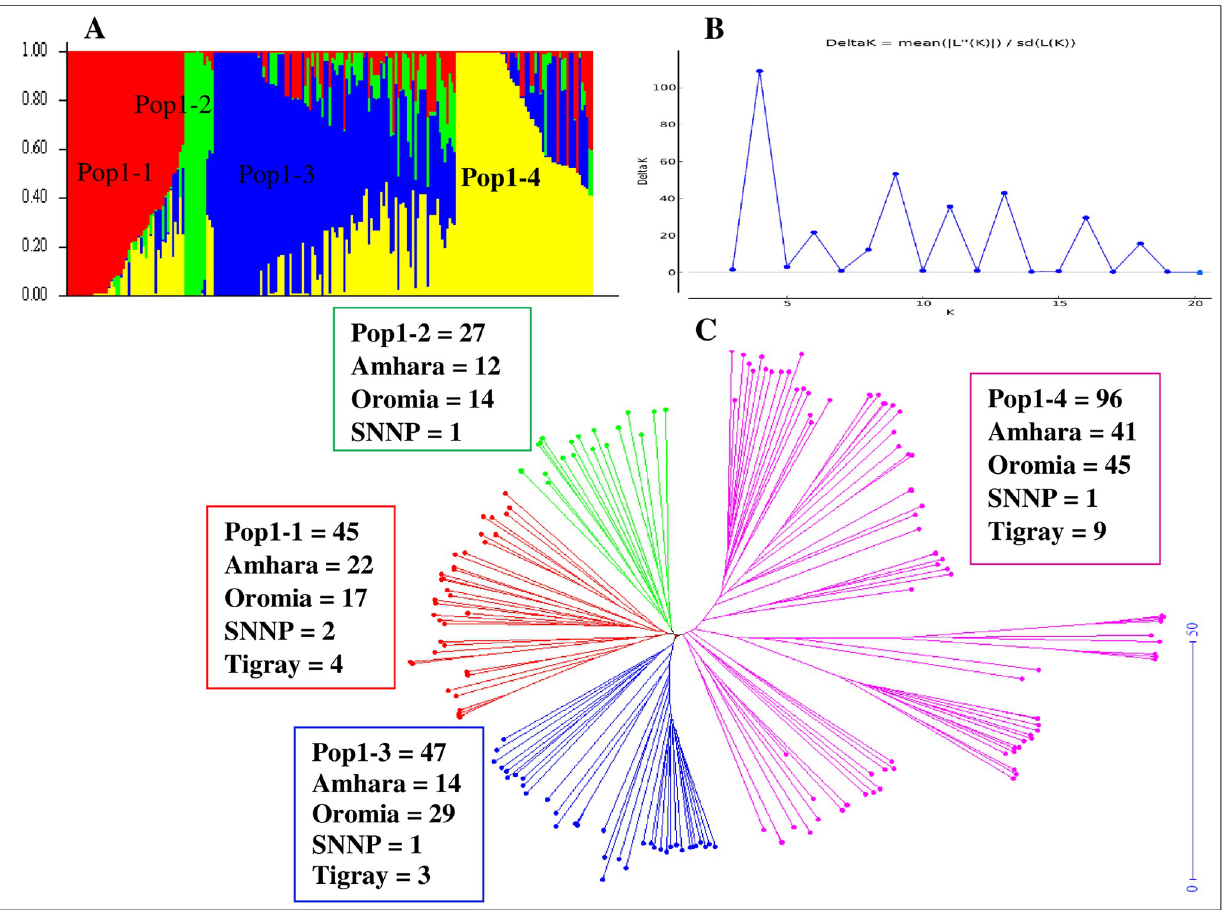
Fig 4. Population structure analysis of ETDWL. (A) Bayesian structure analysis, (B) Structure harvester Δ K at K = 4. (C) Neighbor-Joining (NJ). Populations identified in STRUCTURE based on Bayesian structure analysis are shown in red, green, blue and yellow/pink, for Pop1-1 to Pop1-4,